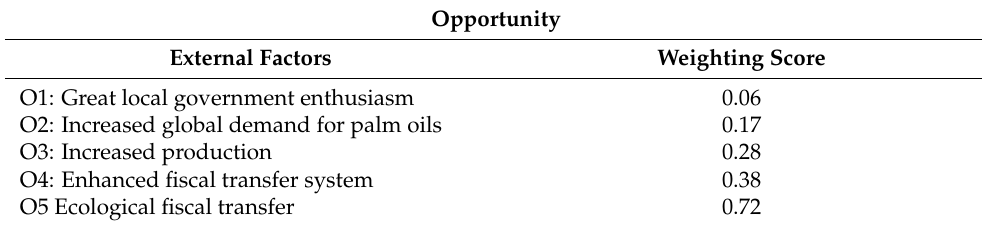
Table 6. Opportunities for the adoption of DBH